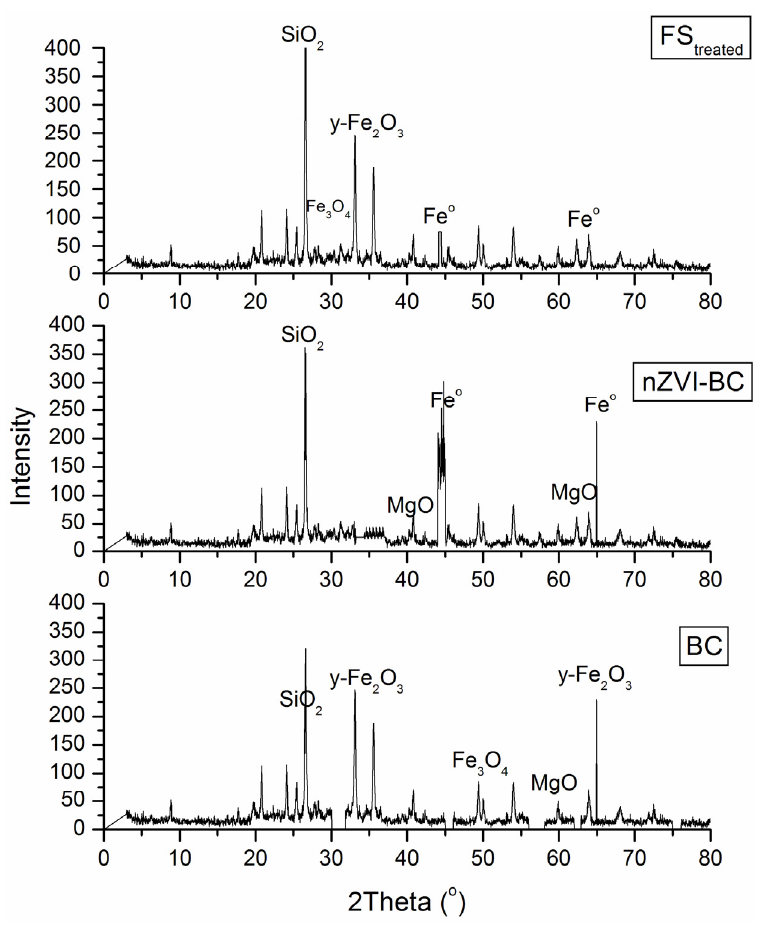
Figure 4. Difractograms of BC, nZVI-BC, and FS treated.